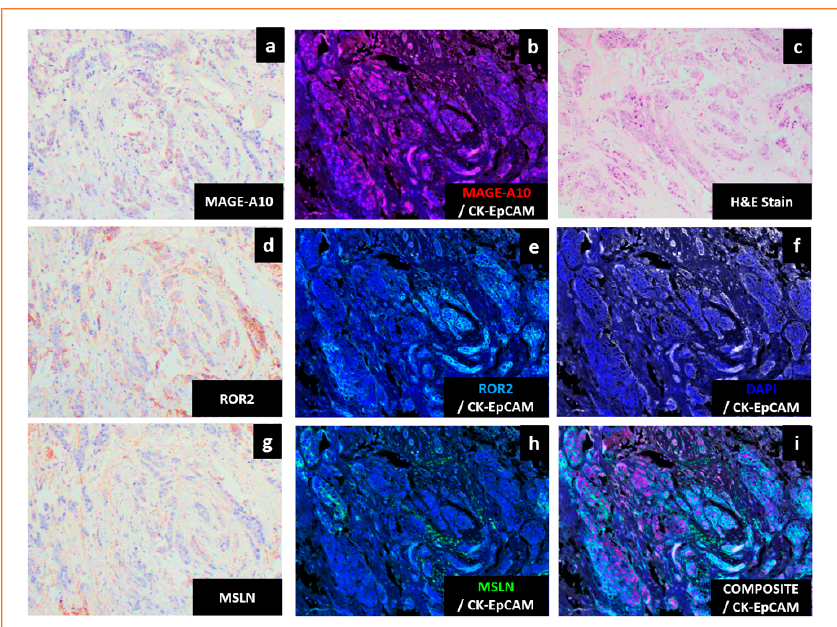
Figure 1. Cancer testis antigens are expressed in triple-negative breast cancers (TNBC). ( a – i ) Representative images of TNBC expressing melanoma antigen gene-A10 (MAGE-A10), receptor tyrosine kinase-like orphan receptor 2 (ROR2) and mesothelin (MSLN). ( a ) Immunohistochemistry (IHC) nuclear staining of MAGE-A10 (brown). ( b ) Multiplex IHC (mIHC) labelling of MAGE-A10 (red), cytokeratin- epithelial cell adhesion molecule (CK-EpCAM) (white) and DAPI (blue). ( c ) Haematoxylin and eosin (H&E) staining. ( d ) IHC membrane staining of ROR2 (brown). ( e ) mIHC labelling of ROR2 (cyan), CK-EpCAM (white) and DAPI (blue). ( f ) mIHC labelling of CK-EpCAM (white) and DAPI (blue). ( g ) IHC membrane staining of MSLN (brown). ( h ) mIHC labelling of MSLN (green), CK-EpCAM (white) and DAPI (blue). ( i ) mIHC labelling of MSLN (green), MAGE-A10 (red), ROR2 (cyan), CK-EpCAM (white) and DAPI (blue). H&E, IHC and mIHC were used to stain serial sections. Magnification: 200 ×.